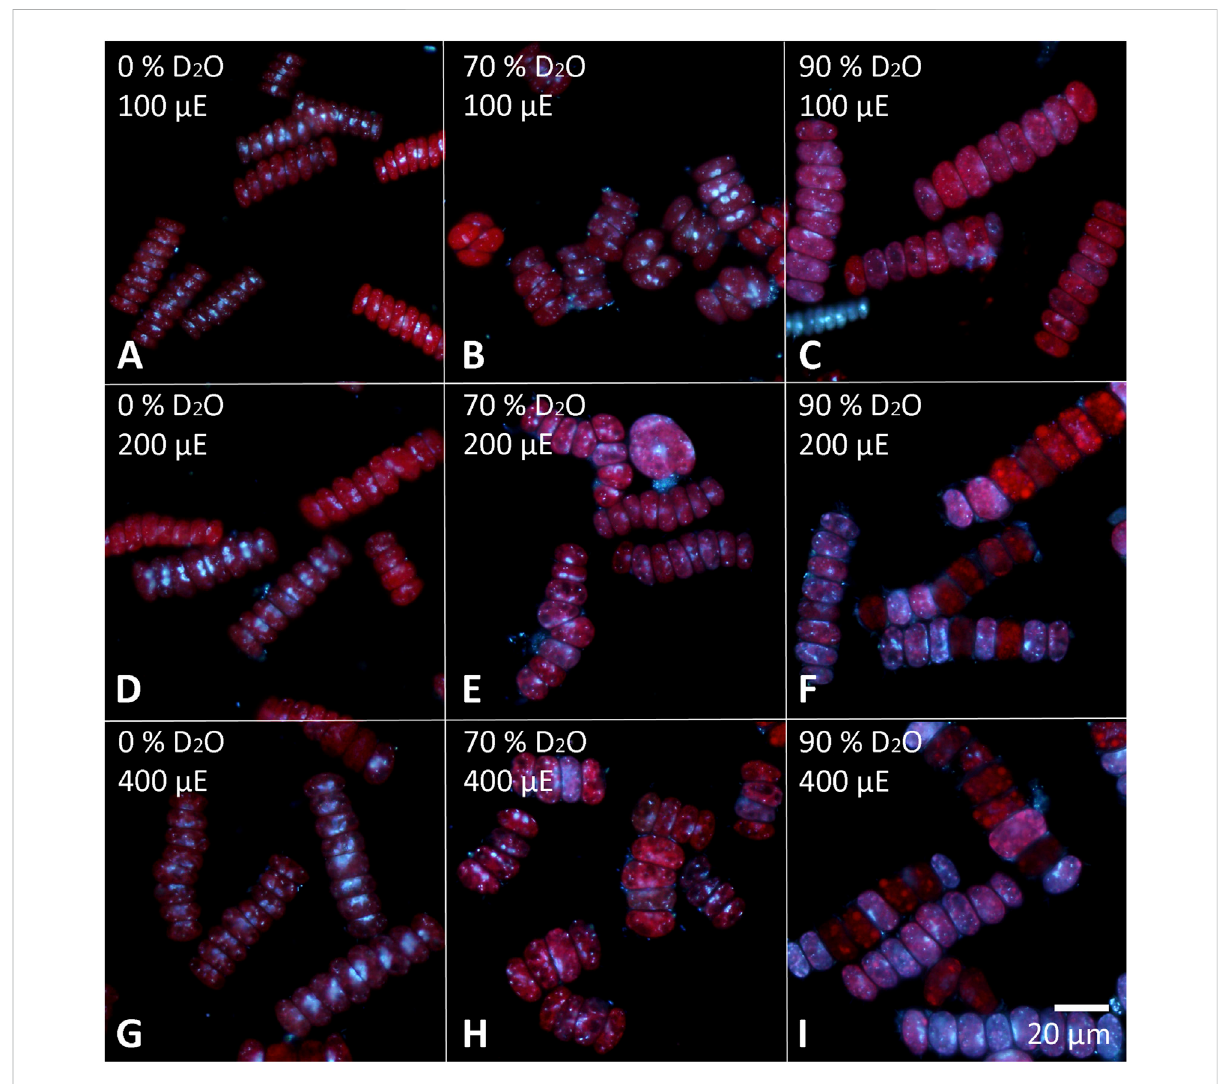
FIGURE 8 Cellsof D.quadricauda stainedwithDAPItovisualizethenuclei.Cellsculturedin0 (A,D,G) ,70 (B,E,H) or90% (C,F,I) D2O(fromlefttoright)atanincident lightintensityof100 (A,B,C) ,200 (D,E,F) or400 (G,H,I) μ molphotonsm − 2 s − 1 (denotedas μ Einthe fi gure;fromtoptobottom)werestainedafter48